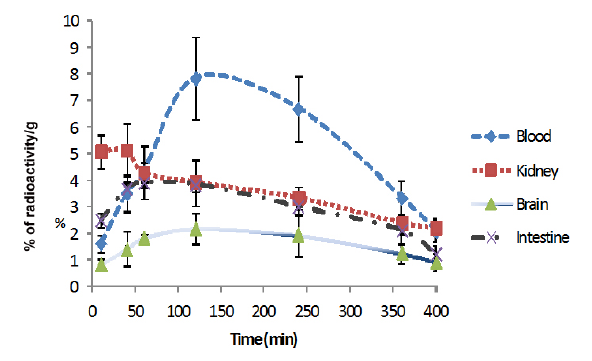
Figure 1. Distribution of the venom after subcutaneous injection in various organs in rats. Values are the averages obtained from three rats in each group. The times shown represent intervals following venom administration ( 125 I-labeled 10 µg venom per rat).